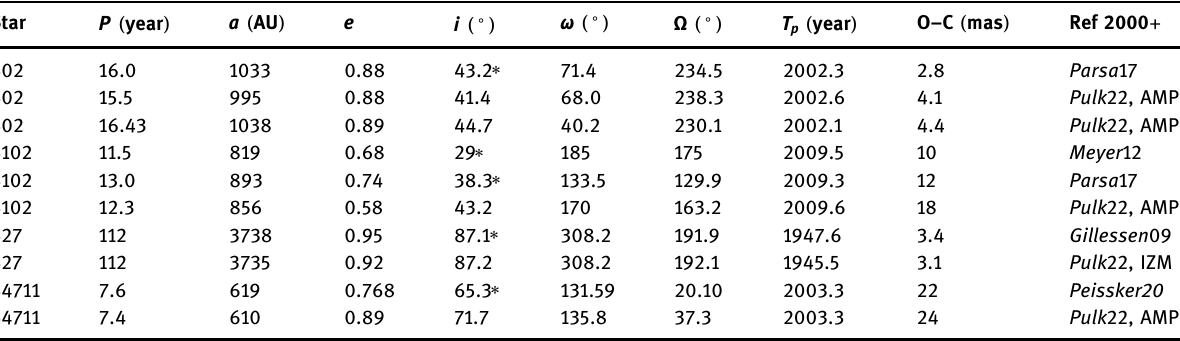
Table 1: Orbital elements of S - cluster stars